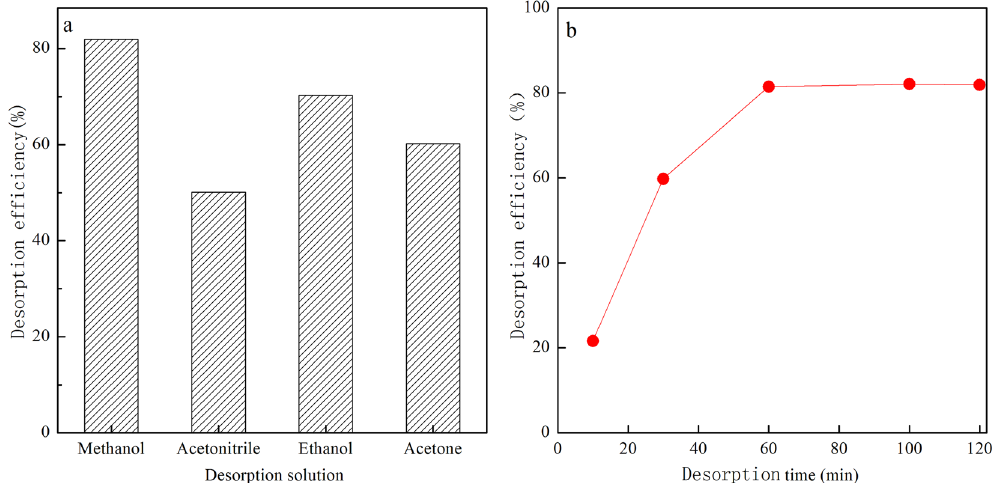
Figure 5. Effects of desorption solvents ( a ) and desorption time ( b ) on the PhOH desorption.